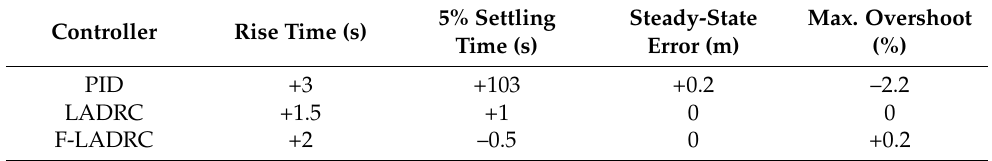
5% Settling Steady-State Max. Overshoot Time (s) Error (m)